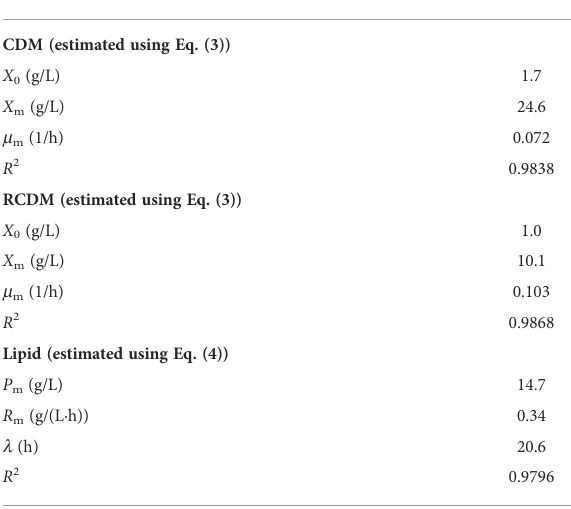
TABLE 4 Kinetic parameters for growth and lipid production of A. limacinum SR21 in fed-batch cultivation using CP-HL based medium.